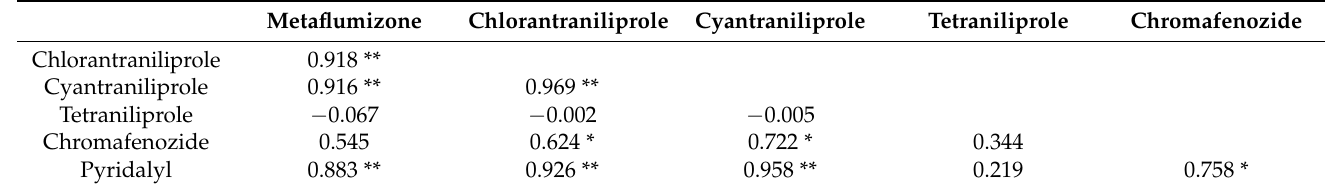
Table 7. Pairwise correlation analysis of the LC 50 values for six insecticides in the eleven field populations of S. litura